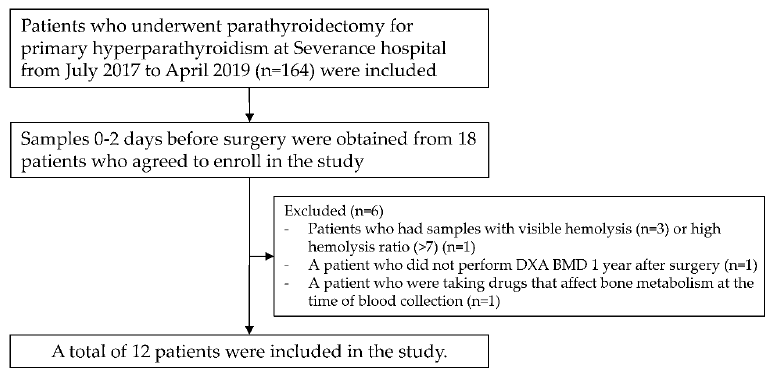
Figure 1. Outline of the study design. Table 1. Baseline characteristics.